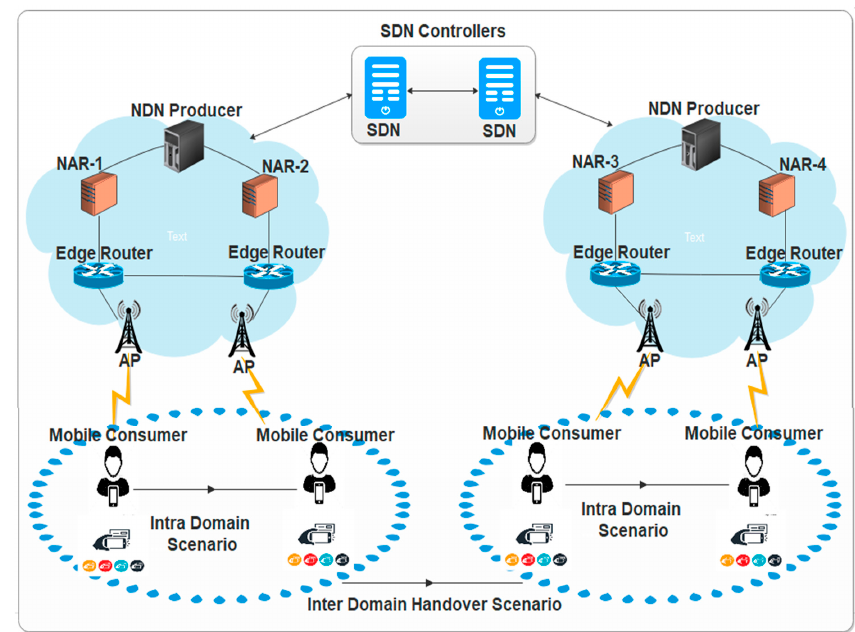
Figure 4. Software-de fi ned mobility architecture for NDN.